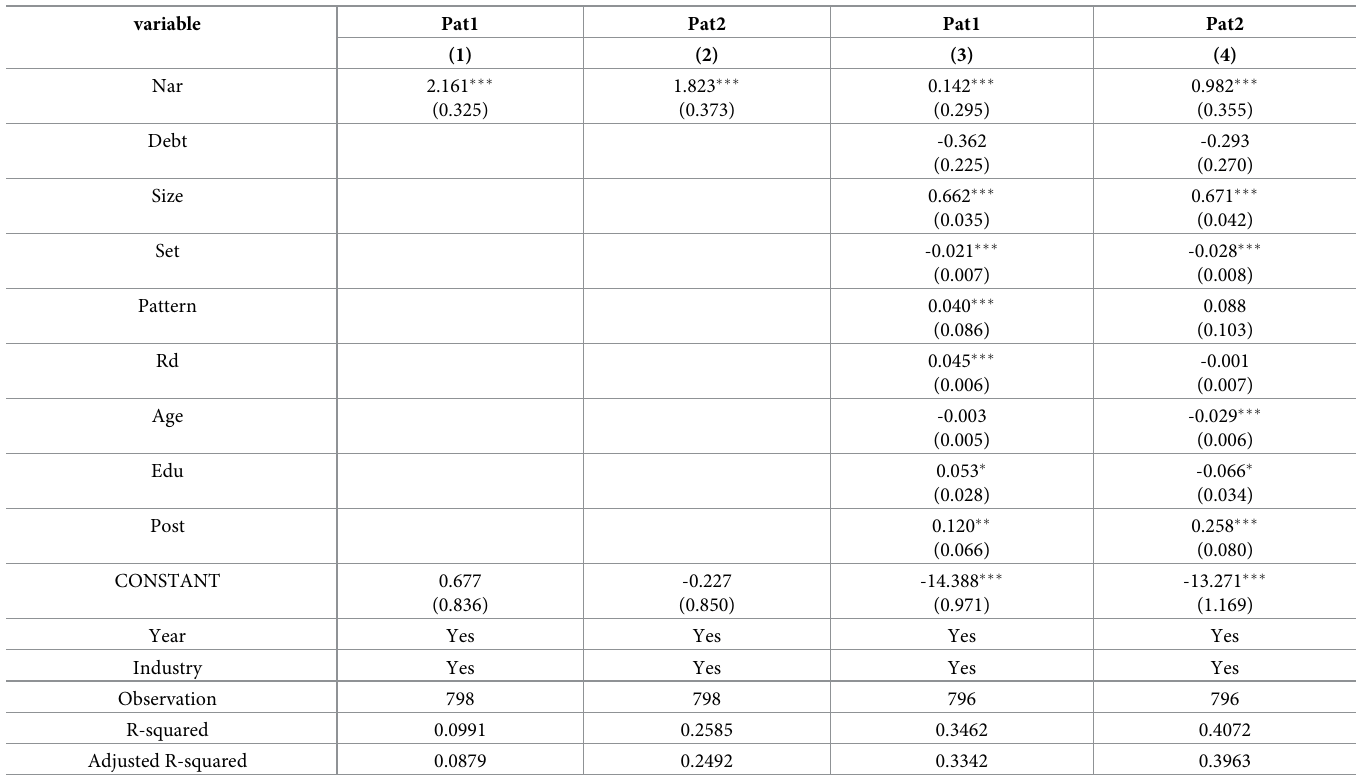
Table 9. One period lag—benchmark regression robustness